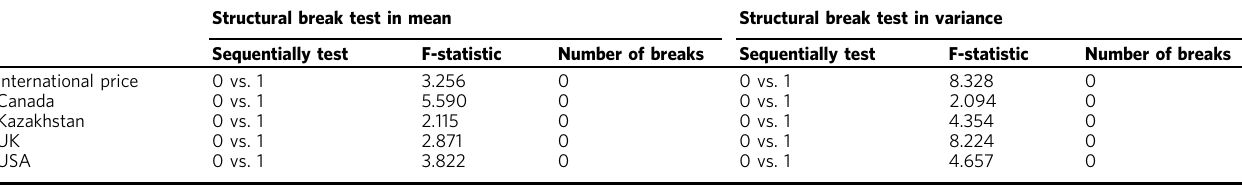
Table 2 Results of the structural break tests in mean and volatility.